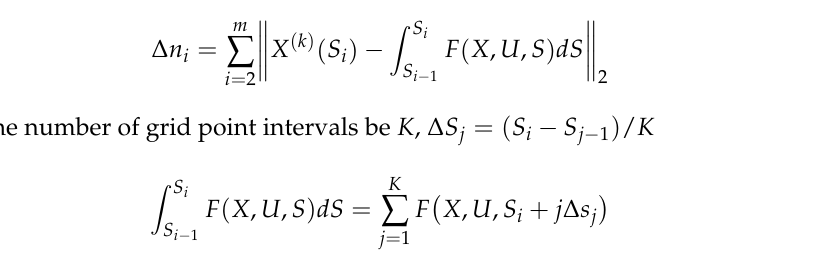
Figure 3. Fast initial trajectory setting method:( a ) represents the change of landing points with a minor attack angle; ( b ) represents the change of landing points with a high attack angle.